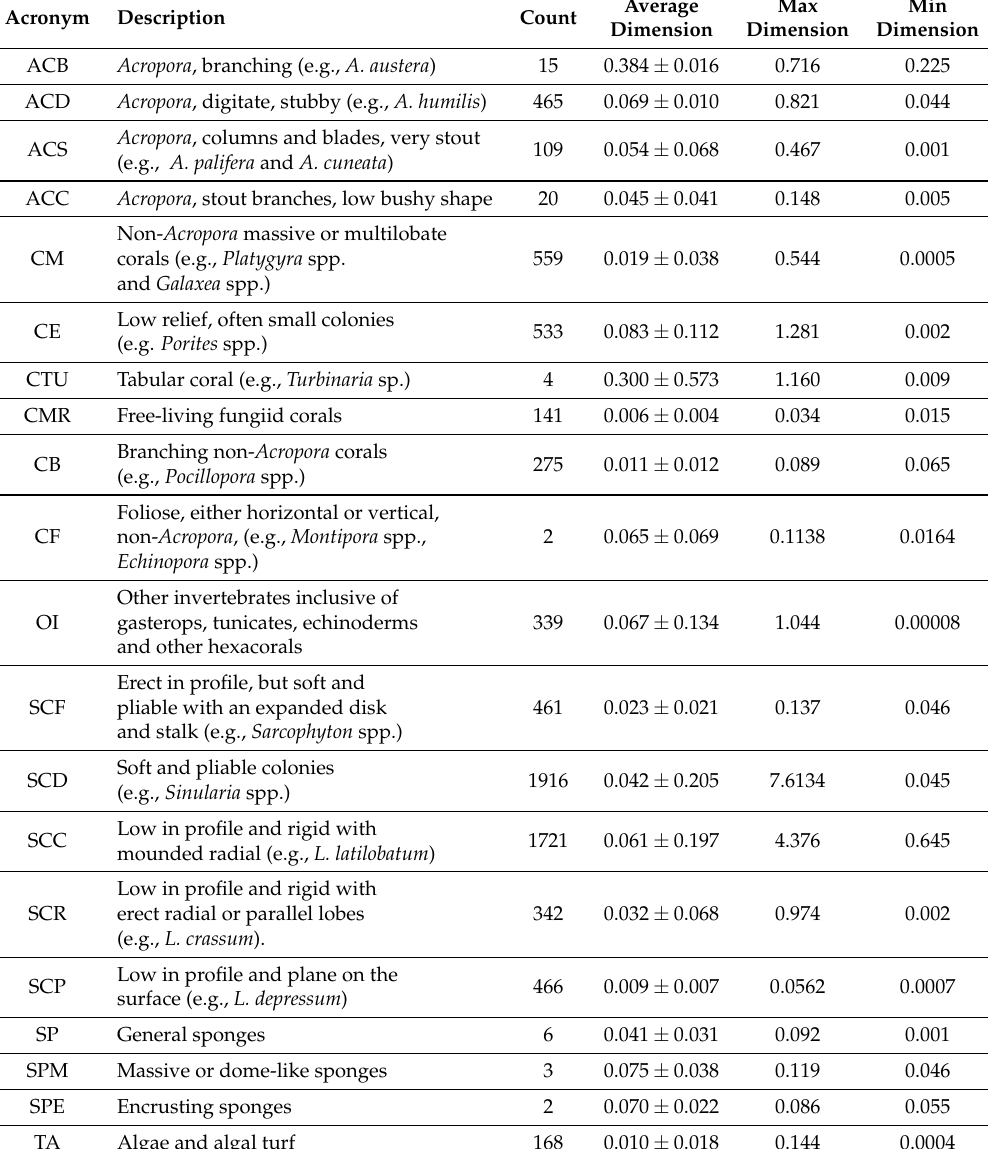
Table 2. Description of the key morphological classes of benthic organisms and their count, maximum (max), minimum (min) and average dimensions (m 2 ), identified within the coral reef studied in the Partial Marine Reserve of Ponta do Ouro